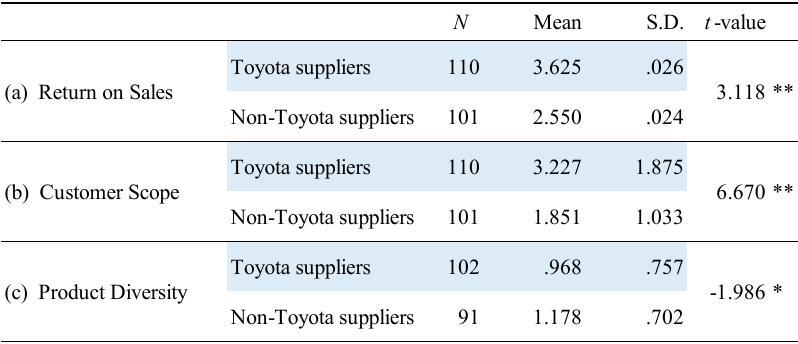
Table 3. Comparisons between Toyota suppliers and non-Toyota suppliers